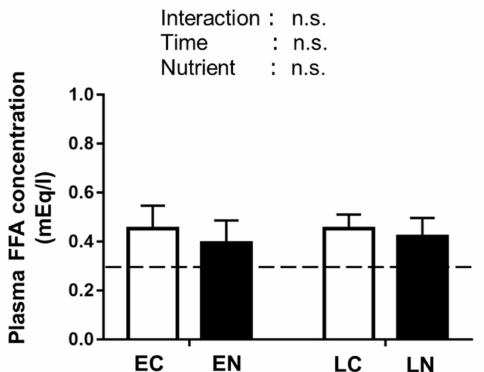
Figure 5. Plasma free fatty acid (FFA) concentrations in mice at 30 min after oral intake of nutrients or water. The experimental protocol was the same as that described in the Figure 3 legend. Dashed lines indicate the baseline values (B, sedentary control). Values are the mean ± SE. n = 6 or 7 per